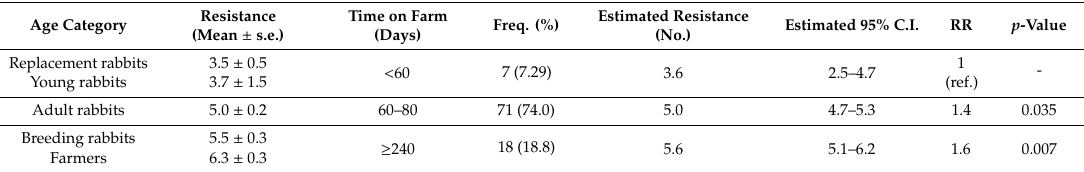
Table 3. Observed and estimated number of class resistance by age category and in-farm time recorded groups. Risk ratios for the increase of youngest one.